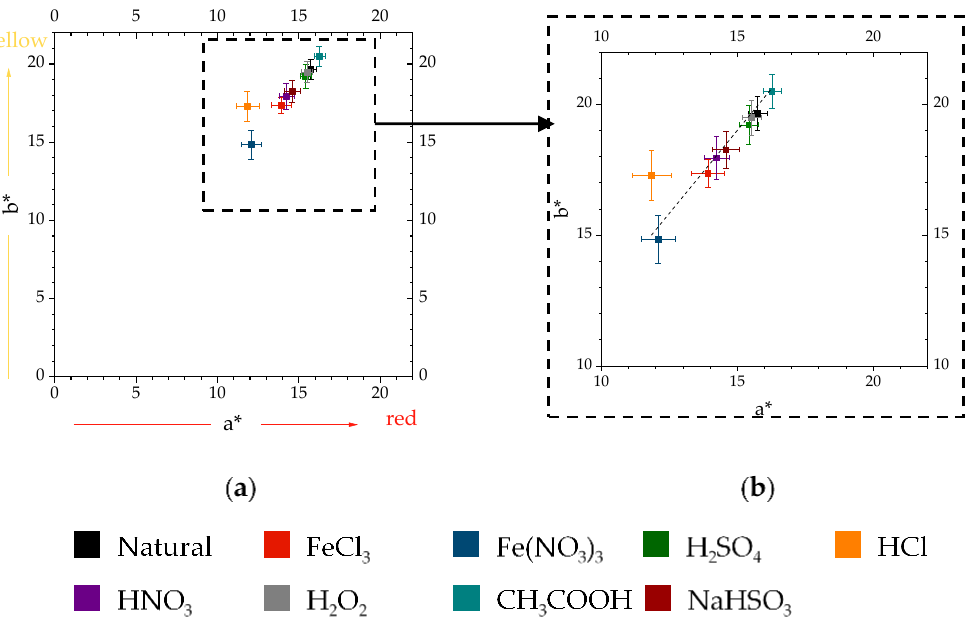
Figure 9. ( a ) The a* and b* values of the natural patina and the accelerated patinas after 24 months of atmospheric exposure and ( b ) amplification of the data, including a lineal regression with a zero intercept. Table 4. Lineal regression fitting forcing to a zero intercept for accelerated patinas at zero time (prior to atmospheric exposure) and for a natural patina as well as accelerated patinas after different exposure times.